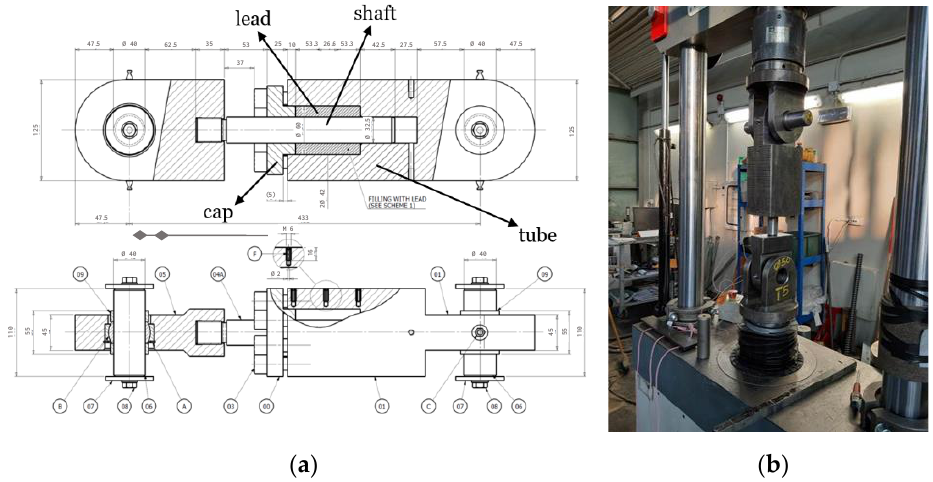
Figure 6. PS-LED experimentally assessed in the study: ( a ) shop drawing; ( b ) prototype on the testing machine [41].